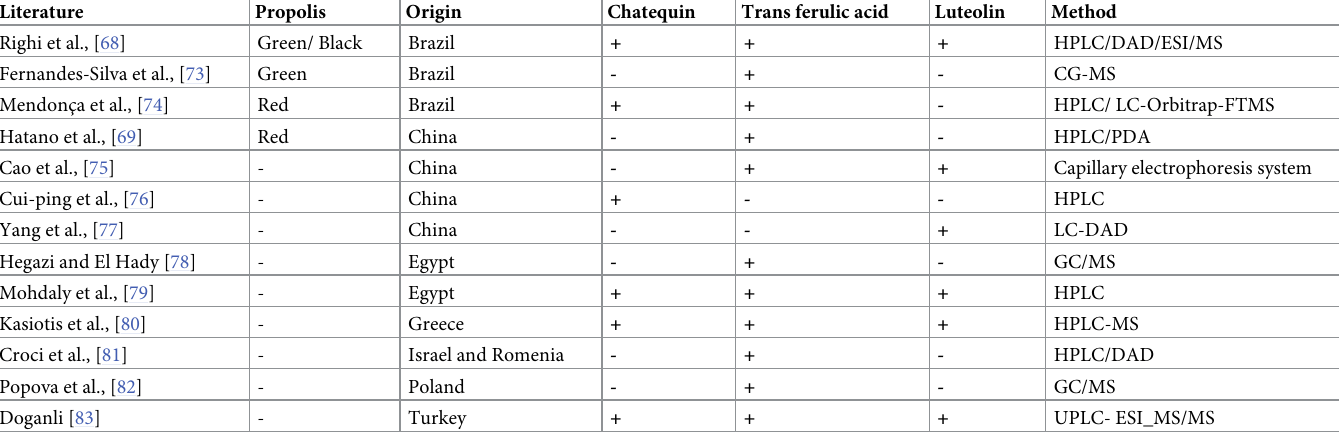
Table 4. Bibliographical review of recent studies on the quantification of the compounds catechin, ferric acid and luteolin in extracts of propolis from different regions.